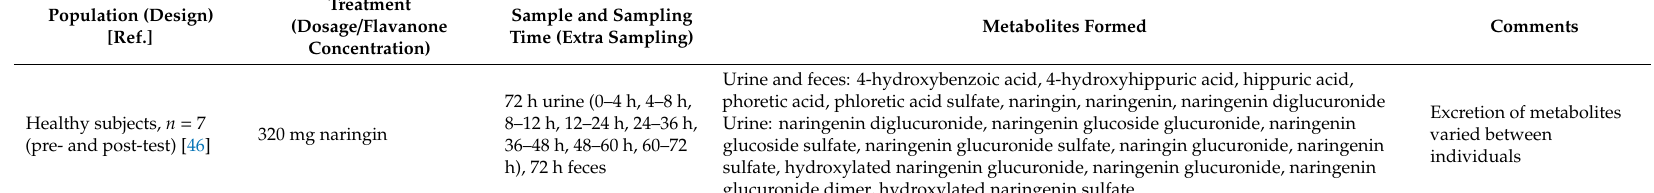
Table 2. Nonexclusive listing of studies investigating the metabolism and bioavailability of citrus flavanones in human subjects. Population (Design)